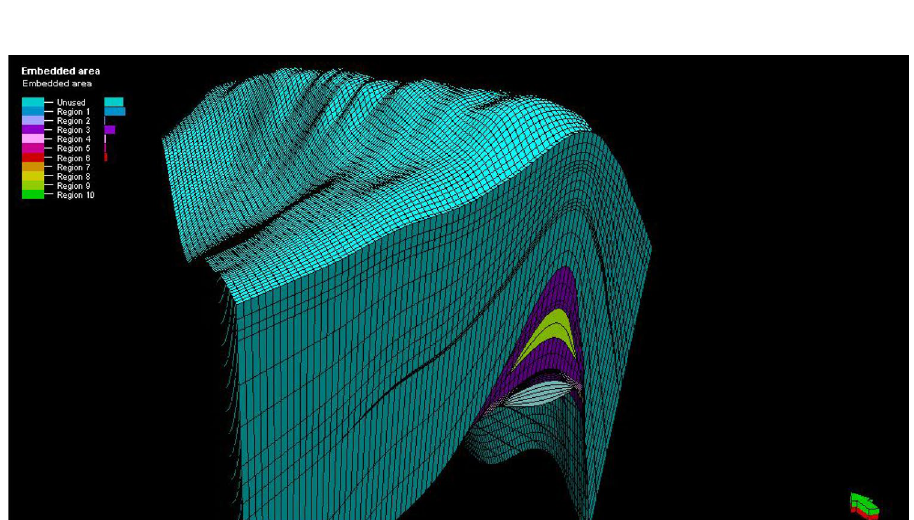
Fig. 8 Final geomechanical grid for the area surrounding the